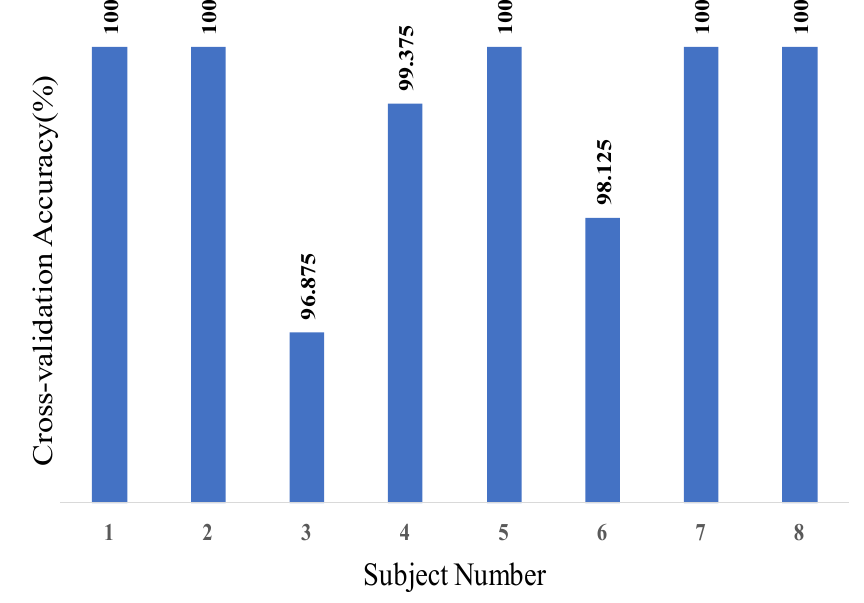
Figure 19. Cross-validation accuracies of eight subjects. Figure 19. Cross ‐ validation accuracies of eight subjects. Table 2. Normalized confusion matrix of % of classification results.